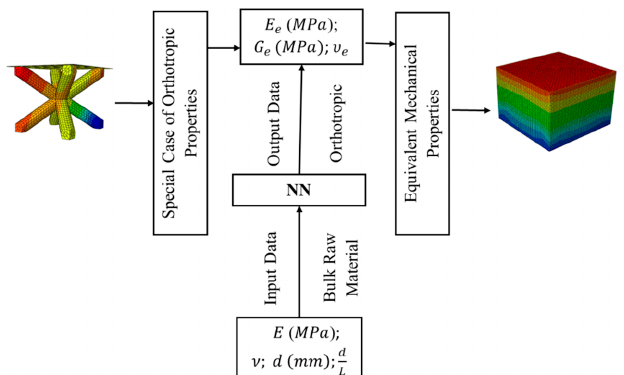
Figure 1. A methodology strategy from finite element analysis (FEA) model to neural networks (NN) model to Equivalent solid model.